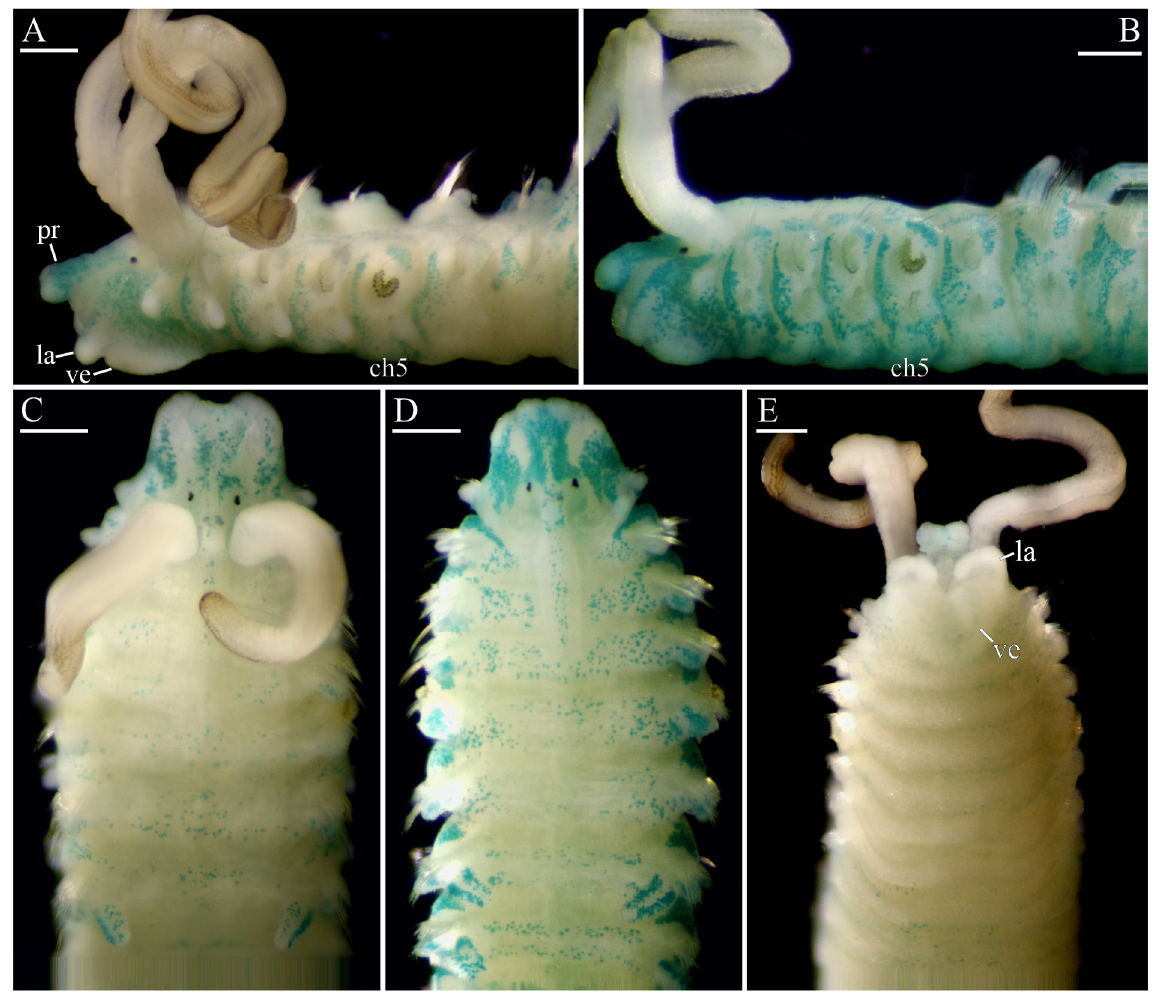
Fig. 17. Adult morphology of Pseudopolydora melanopalpa sp. nov. (formalin-fixed and stained with MG specimens). A . Holotype (MIMB 40908). B–E . Paratypes (MIMB 40909). A – E . Anterior ends, left lateral (A–B), dorsal (C–D), and ventral (E) view. Abbreviations: ch5 = chaetiger 5; la = lateral peristomial lip; pr = prostomium; ve = ventral peristomial lip. Scale bars = 200